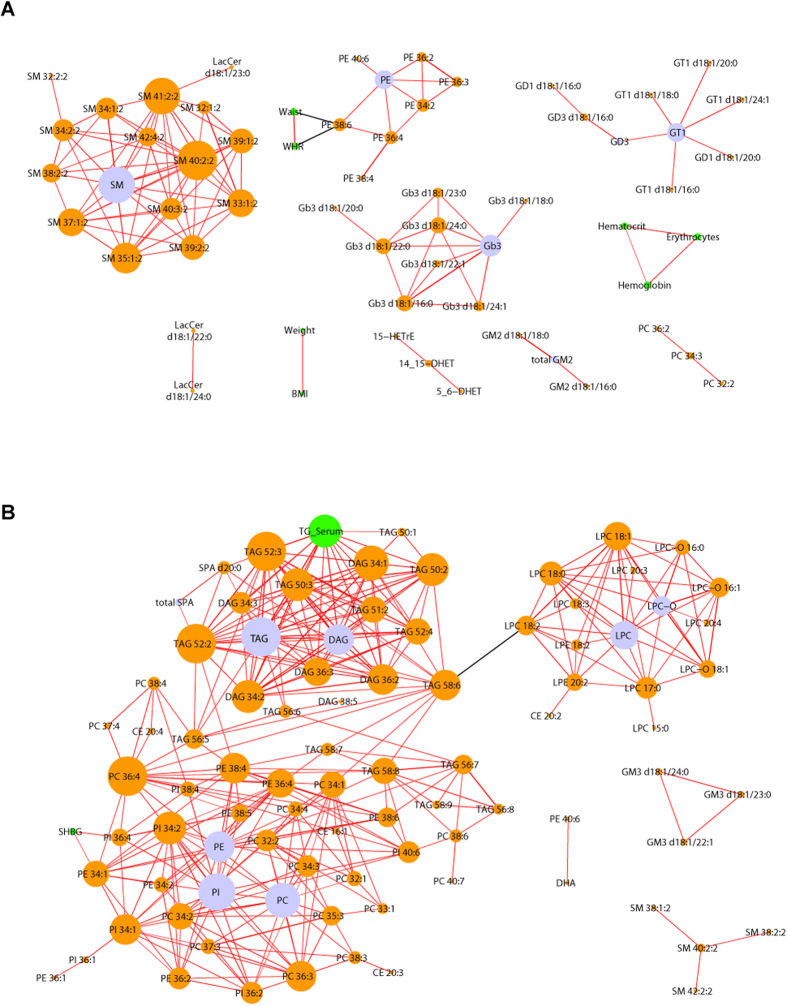
Correlation network of clinical and lipidomic values of males vs nonCC-females (A) and CC-females vs nonCC-females (B). The green nodes are the significantly changed clinical and anthropometric indices; the orange and blue nodes are significantly changed lipid species and classes, respectively. Red edges stand for positive and black edges for negative correlation. The size of nodes reflects the number of its significant correlations.